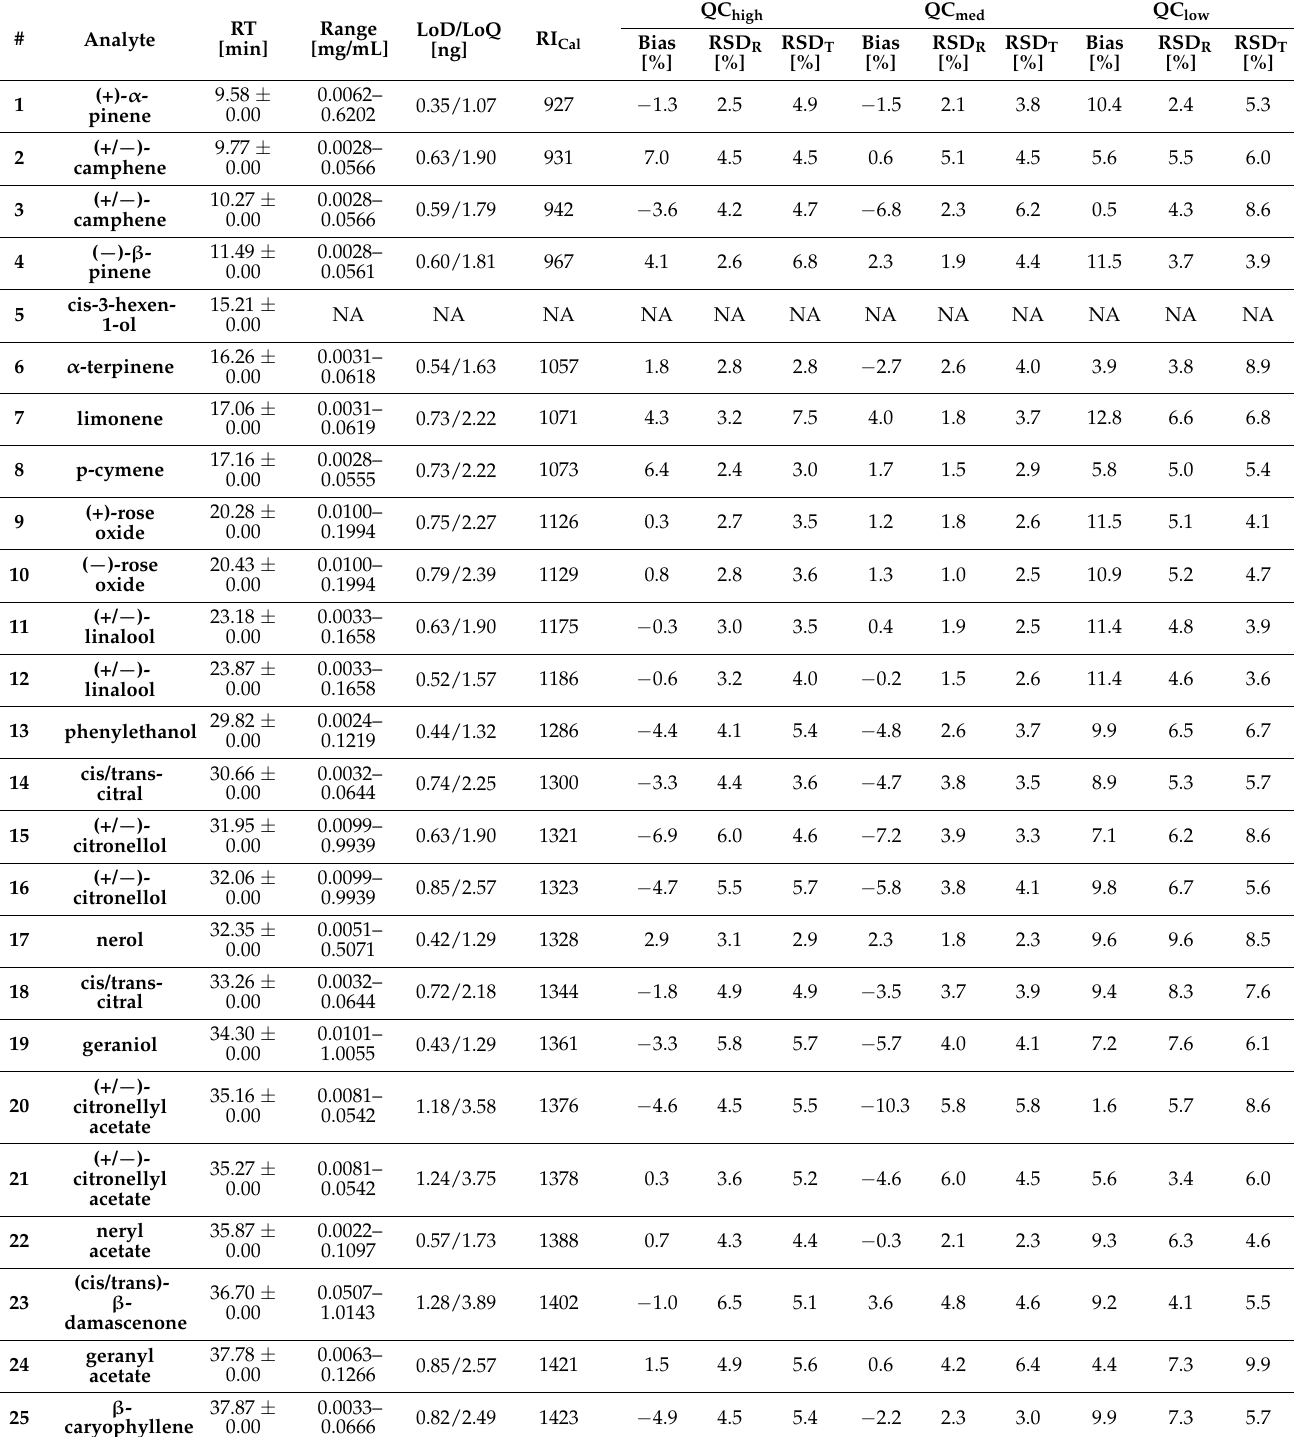
Table 2. Retention times and results for the validation of 30 rose oil compounds analysed on the chiral column with